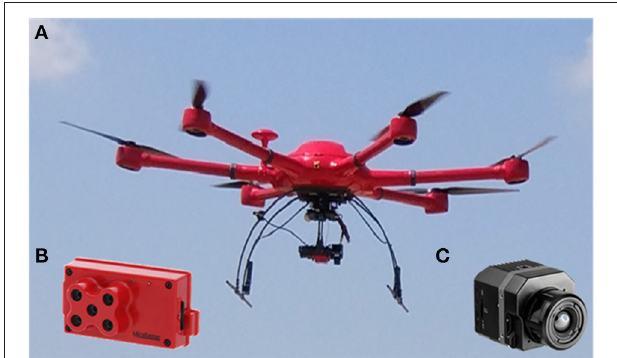
FIGURE 2 | Unmanned aerial vehicle (UAV) and cameras used in the study. (A) UAV, (B) Multispectral Micasense Rededge, and (C) Thermal Flir Vue Pro